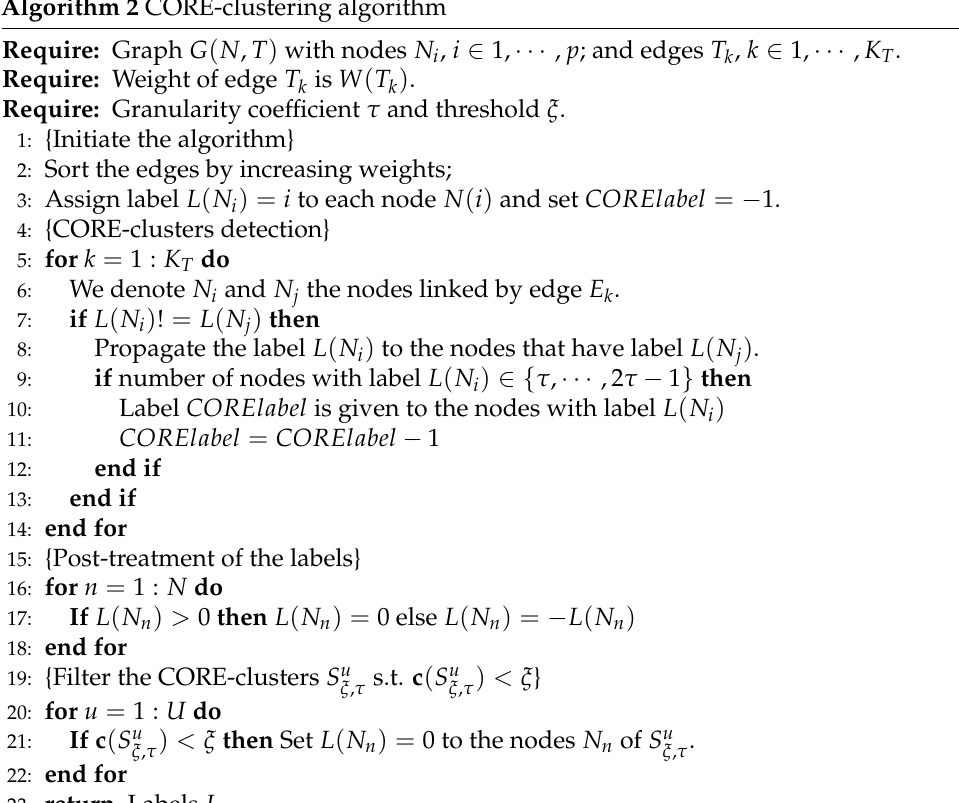
Algorithm 2 CORE-clustering